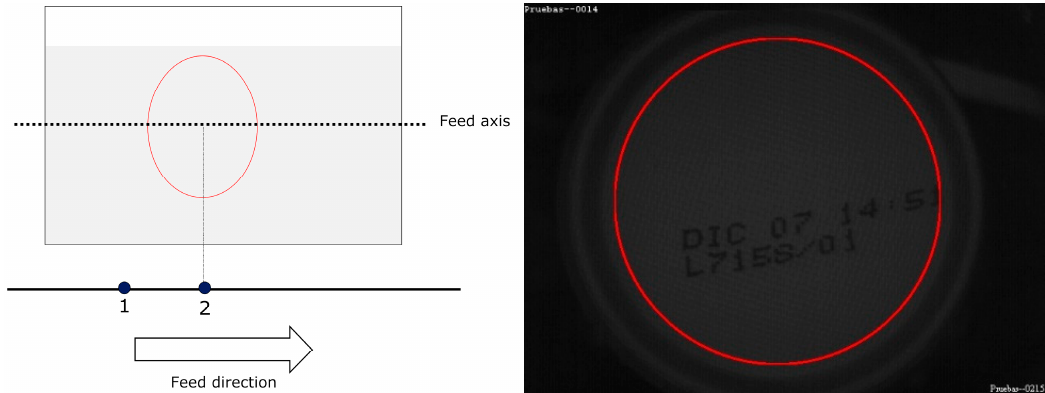
Figure 6 . No event occurs. There are no cans in the entry field.